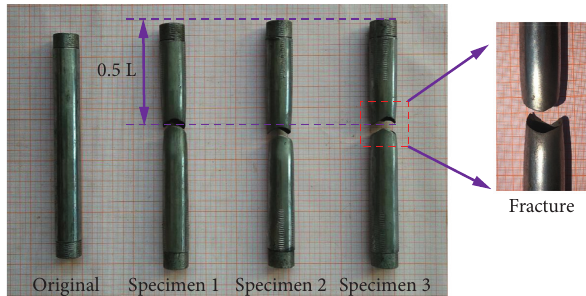
Figure 2: Fracture patterns with an uncorroded pipe under uni- axial stretch.